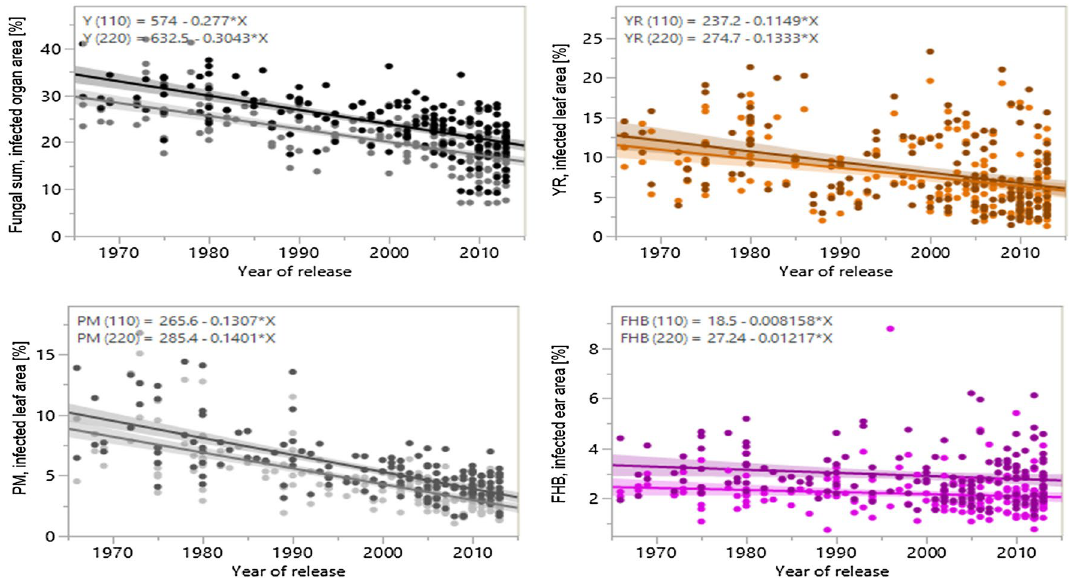
Figure 3. Breeding progress in German winter wheat against fungal pathogens. Development of susceptibility to four fungal pathogens (Fungal sum), stripe rust (YR), powdery mildew PM), and Fusarium head blight (FHB) of 178 winter wheat cultivars across 50 years at two N rates (treatments without plant protection) based on LSmeans (treatment-specific, over years and repeats). Linear trend lines of each disease is given for low N (110 kg N ha −1 , lighter colour) and high N input (220 kg N ha −1 , darker colour), each with 95% confidence interval. Equations of all trendlines are given above each plot.